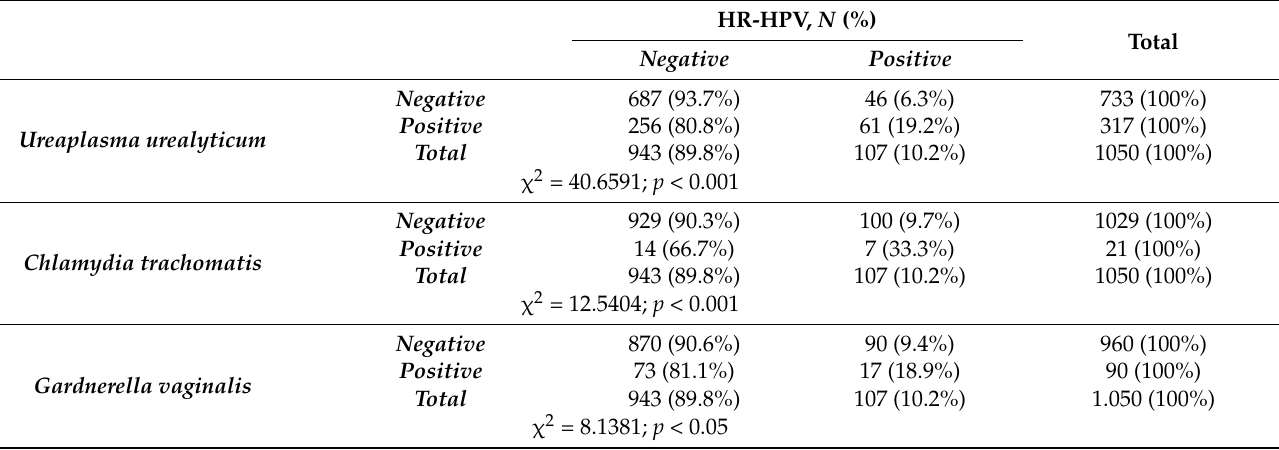
Table 5. Correlation of a positive bacteriological result (Uu, CT, and GV) with a HR-HPV positive test result ( N = 1050).